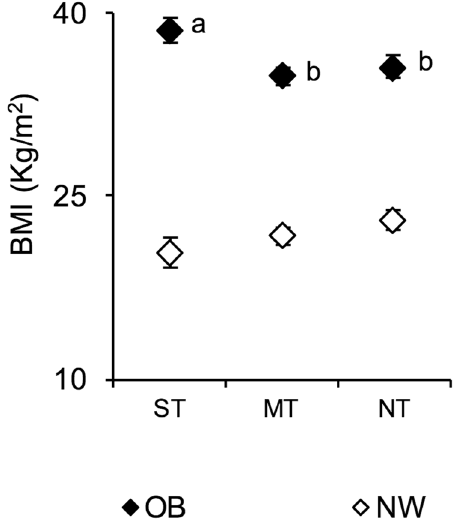
Figure 1. Mean values ± SEM of body mass index (BMI) of supertaster ( N = 9), medium taster ( N = 28) and non-taster ( N = 23) participants with normal weight (NW) and supertaster ( N = 12), medium taster ( N = 25) and non-taster ( N = 13) participants with obesity (OB). A two-way analysis of variance (ANOVA) was used to compare BMIs across taster groups in participants with normal weight or with obesity ( P = 0.013). The different letters indicate significant differences ( P < 0.023; Newman-Keuls test). ST, supertaster participants; MT, medium-taster participants; and NT, non-taster participants.